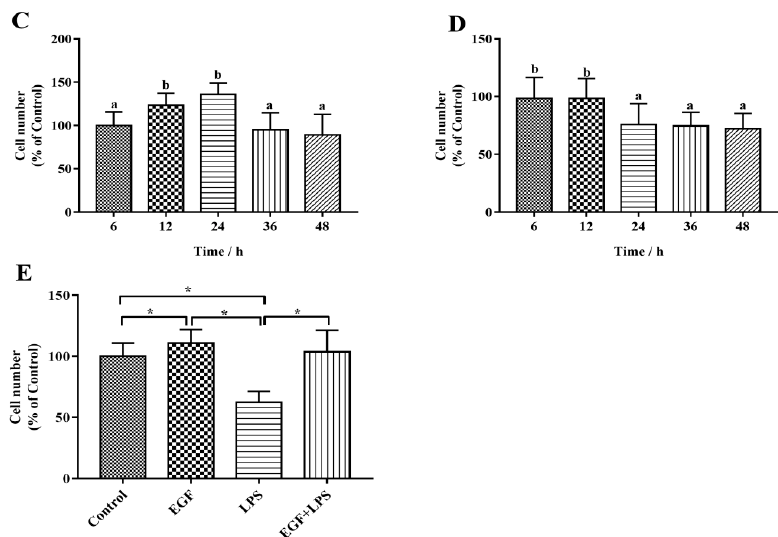
Figure 1. Effects of EGF on cell growth. ( A ) Toxicity of EGF on cell growth; ( B ) Toxicity of LPS on cell growth; ( C ) Time-dependent effects of EGF on cell growth; ( D ) Time-dependent effects of LPS on cell growth; ( E ) Effects of EGF on IPEC-J2 cells growth challenged by LPS. Data are expressed as mean ± SD, n = 6, values with different letters (a, b, c) are significantly different ( p < 0.05), * p < 0.05.